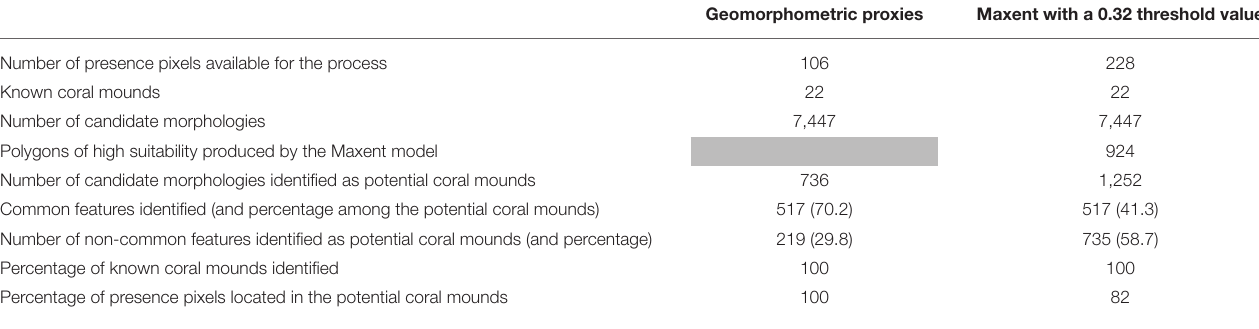
TABLE 4 | Counts of potential coral mounds identified by Geomorphometric proxies and Maxent Method applied on the entire SML area. Geomorphometric proxies Maxent with a 0.32 threshold value